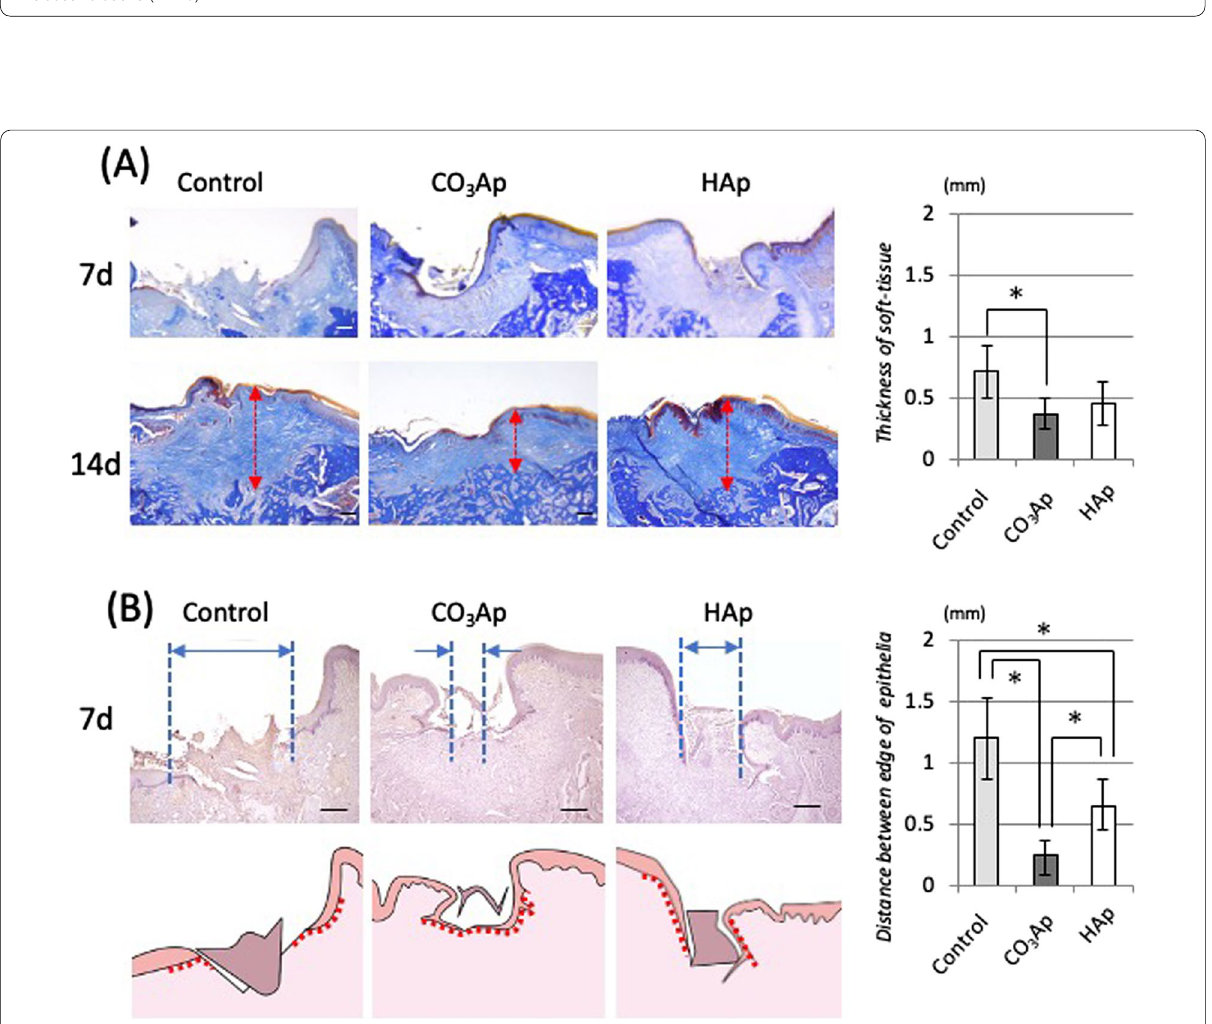
Fig. 5 Soft tissue structures on the healed tooth extraction sockets filled with bone substitute. A Ladewig’s fibrin staining of the covered soft tissue structure. B Immuno-stained histology with Laminin-332. The length of distance between the edges of the epithelial